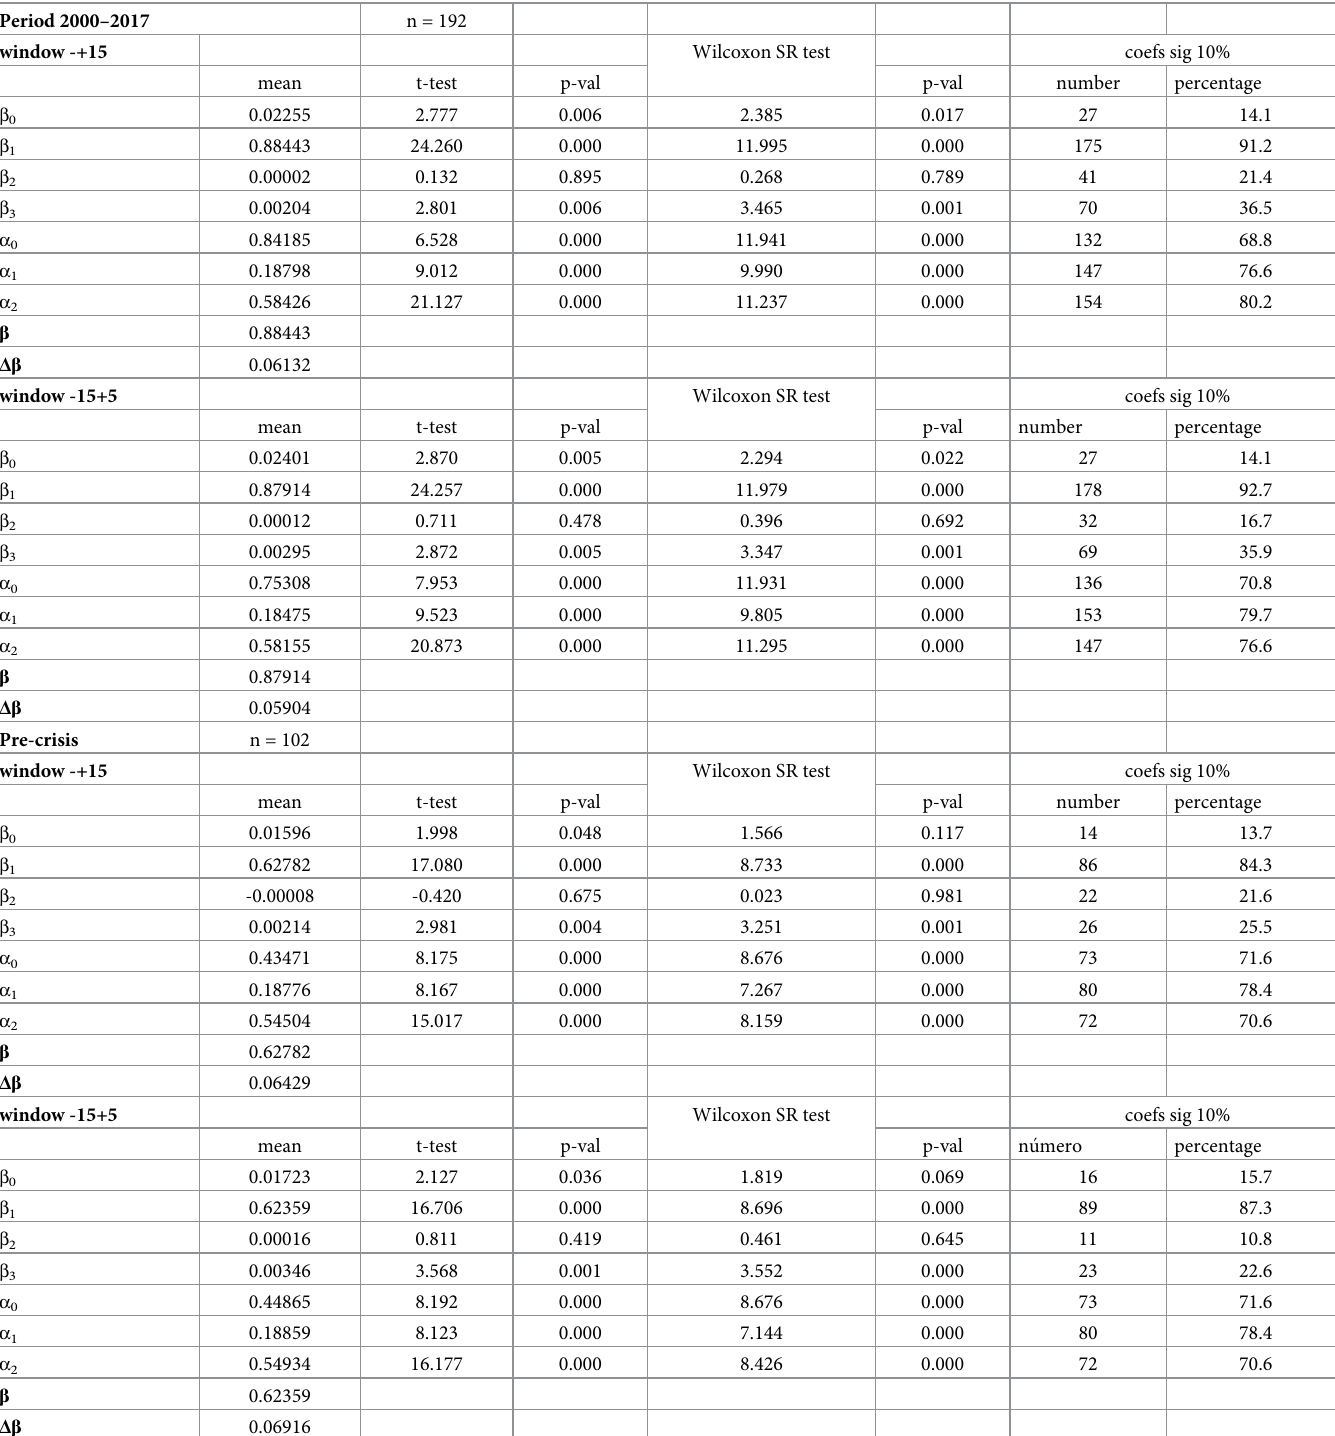
Table 7. Summary results: